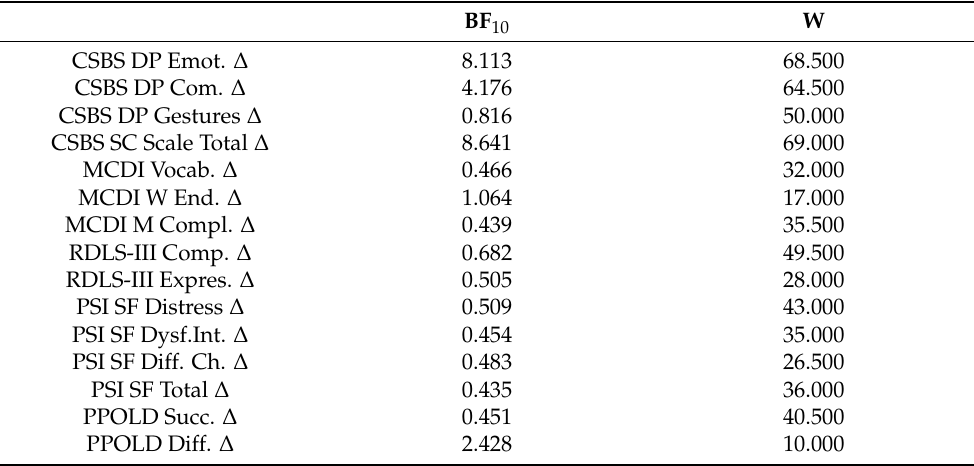
Table 5. Descriptive statistics and the Bayesian Mann-Whitney test was carried out on the ∆ score.